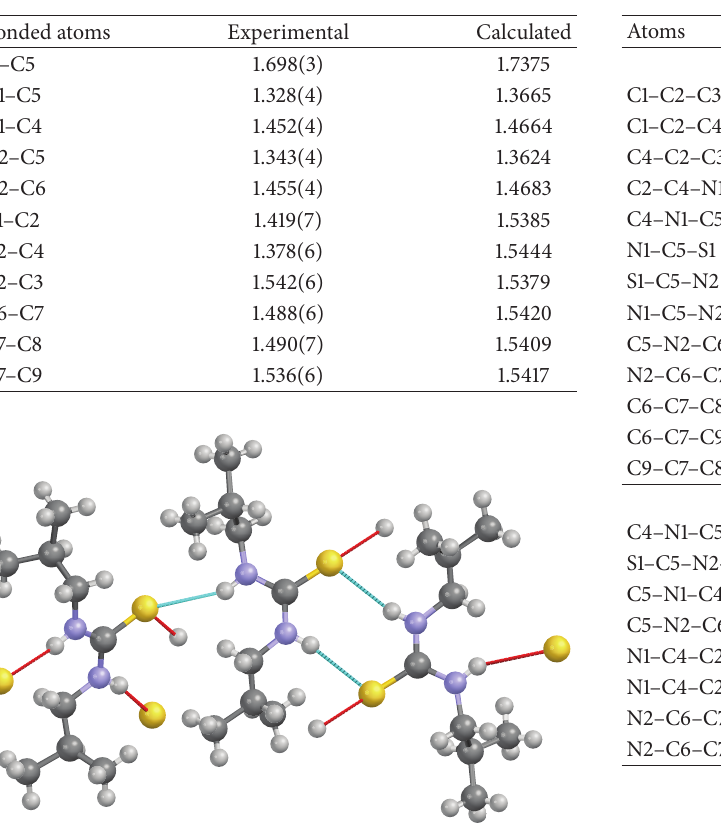
Table 3: Selected bond lengths (experimental and calculated) belong to compound 1 .